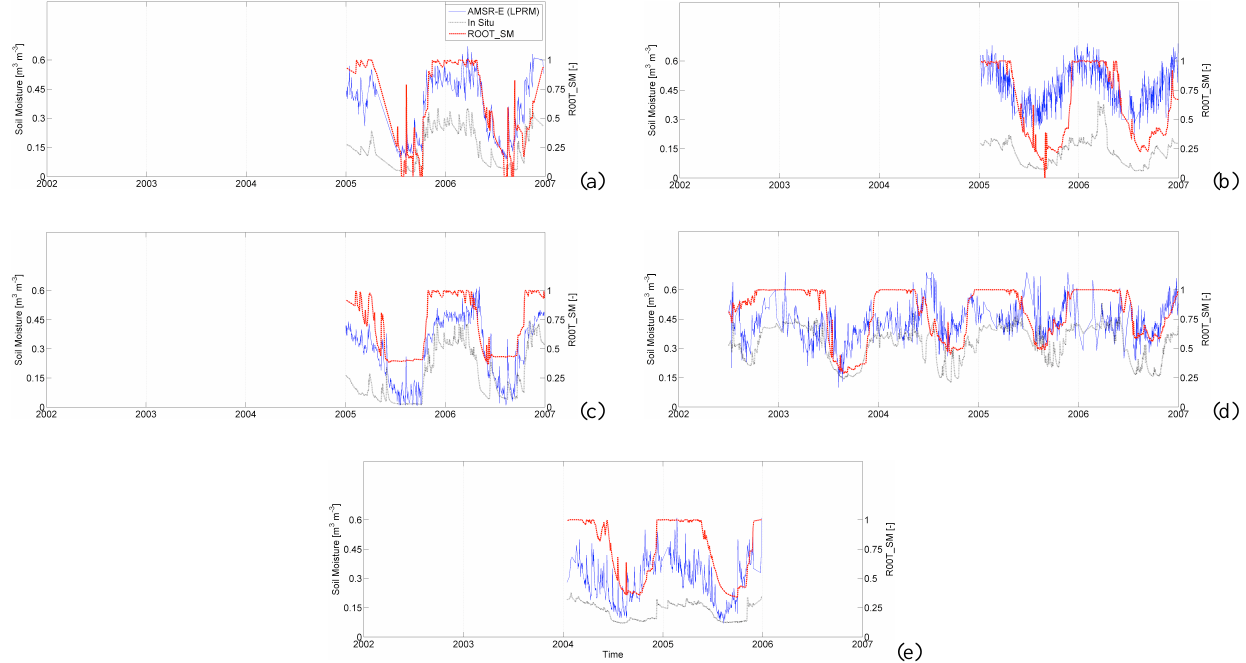
Fig. 3. Time series of AMSR-E, ORCHIDEE ROOT SM and in situ FLUXNET soil moisture data of (a) Majadas del T, Spain (# 2), (b) Le Bray, France (# 4), (c) Mitra IV, Portugal (# 6), (d) Hainich, Germany (# 9) and (e) Metolius Pine, USA, (#